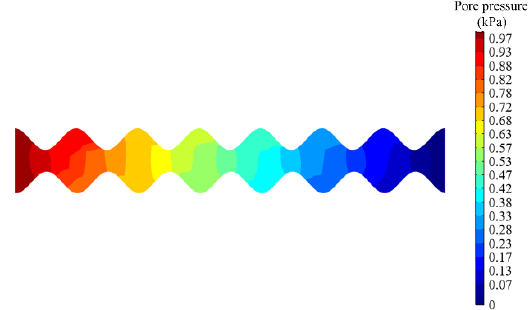
Figure 6. The nearly stable pore pressure distribution.